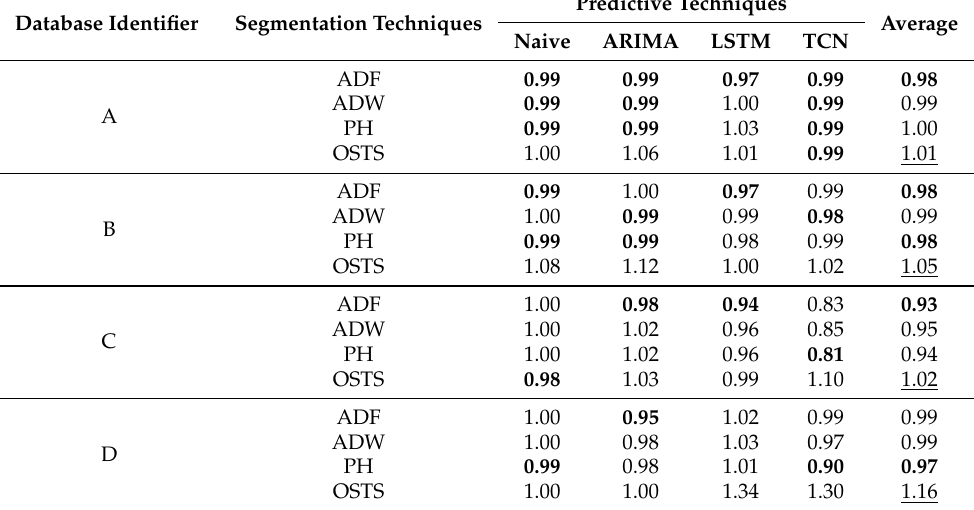
Table 5. Relative RMSE of each segmentation technique referring to the original base across four different predictive techniques using the ADF-based method, ADW, and PH (i.e., instances of our segmentation framework), and OSTS segmentation method. Lower errors are in bold and worst average cases are